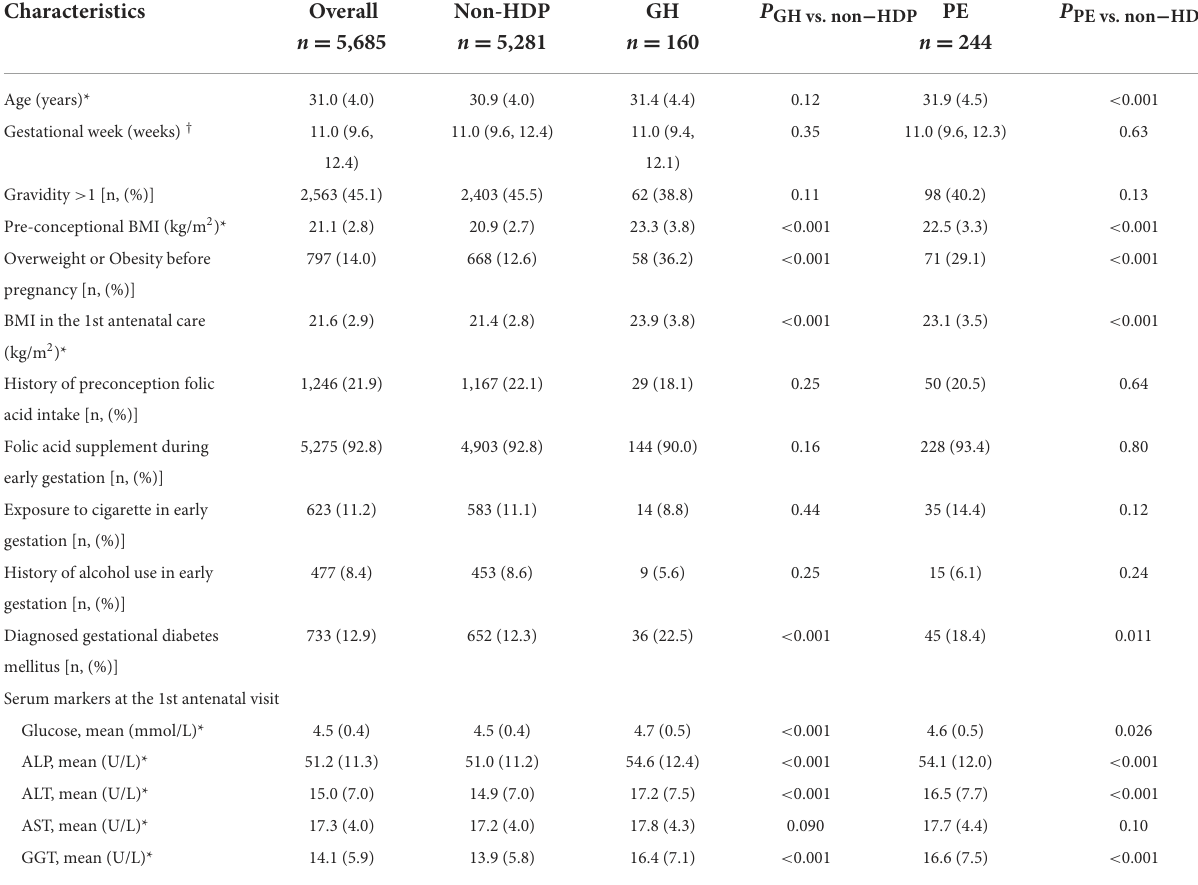
TABLE 1 Demographic characteristics of the study